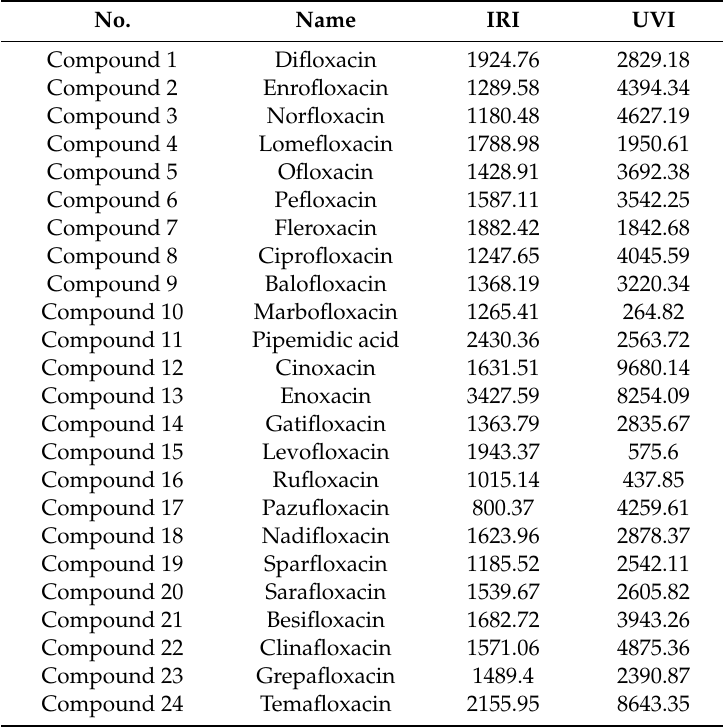
Table 1. Infrared spectral intensity (IRI) and ultraviolet spectral intensity (UVI) of 24 quinolone antibiotics